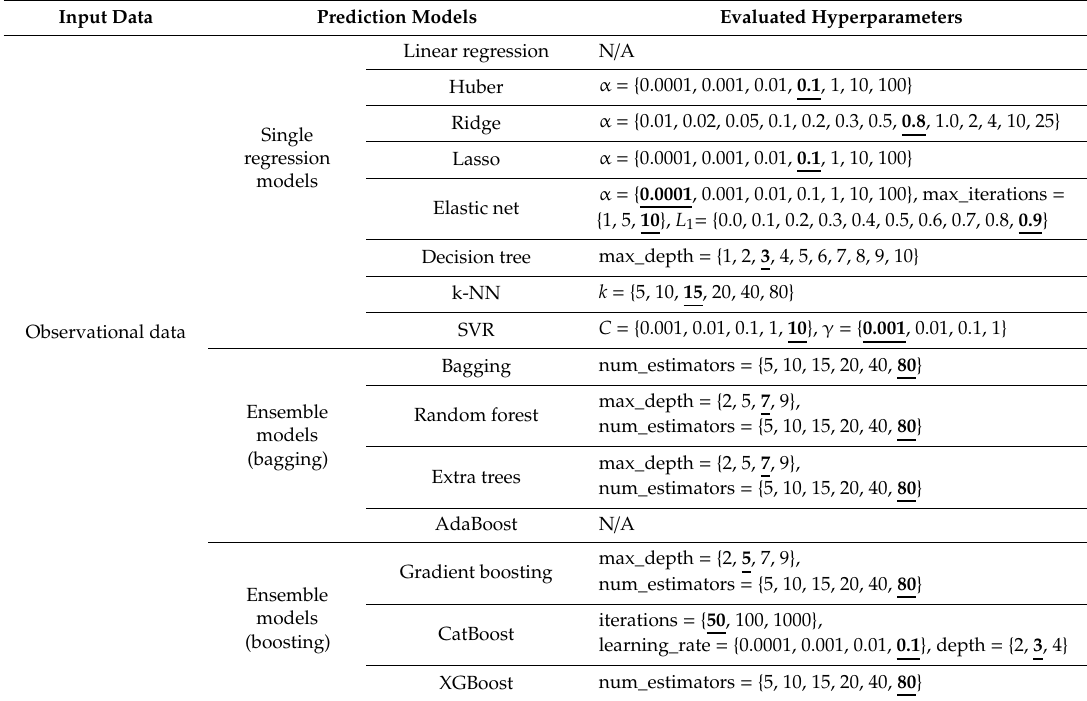
Table A1. Hyperparameter tuning using grid search for the machine learning